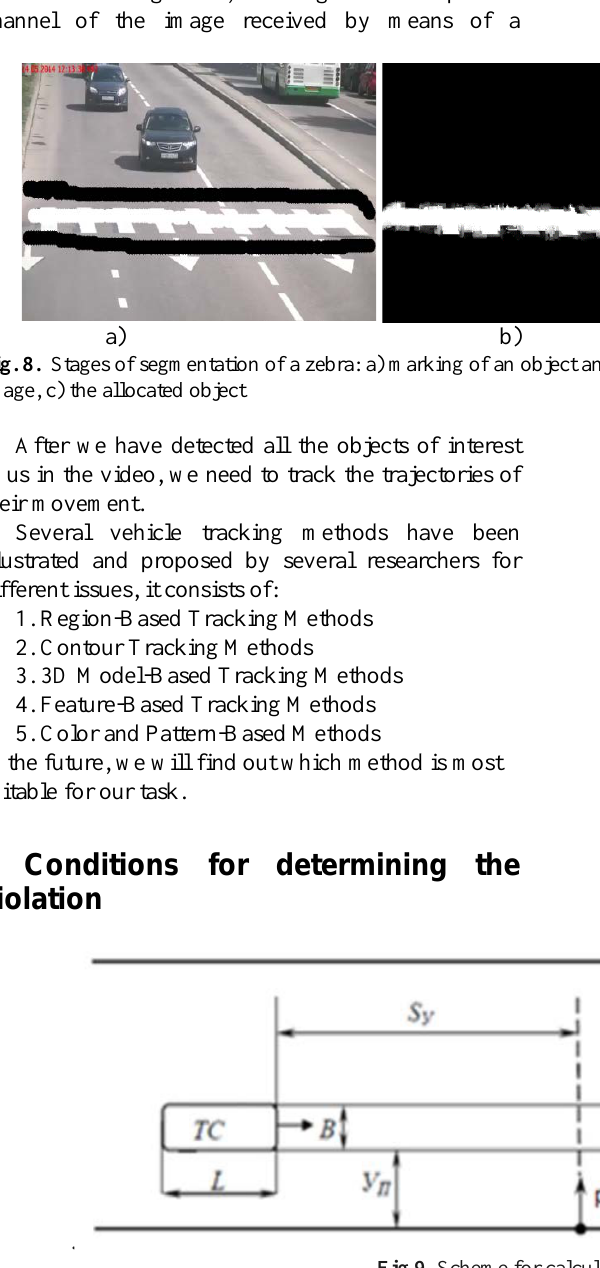
Fig.9. Scheme for calculating safe